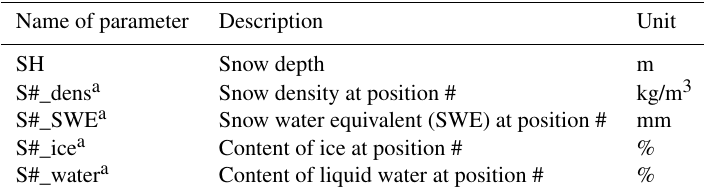
Table 6. List of snow parameters.